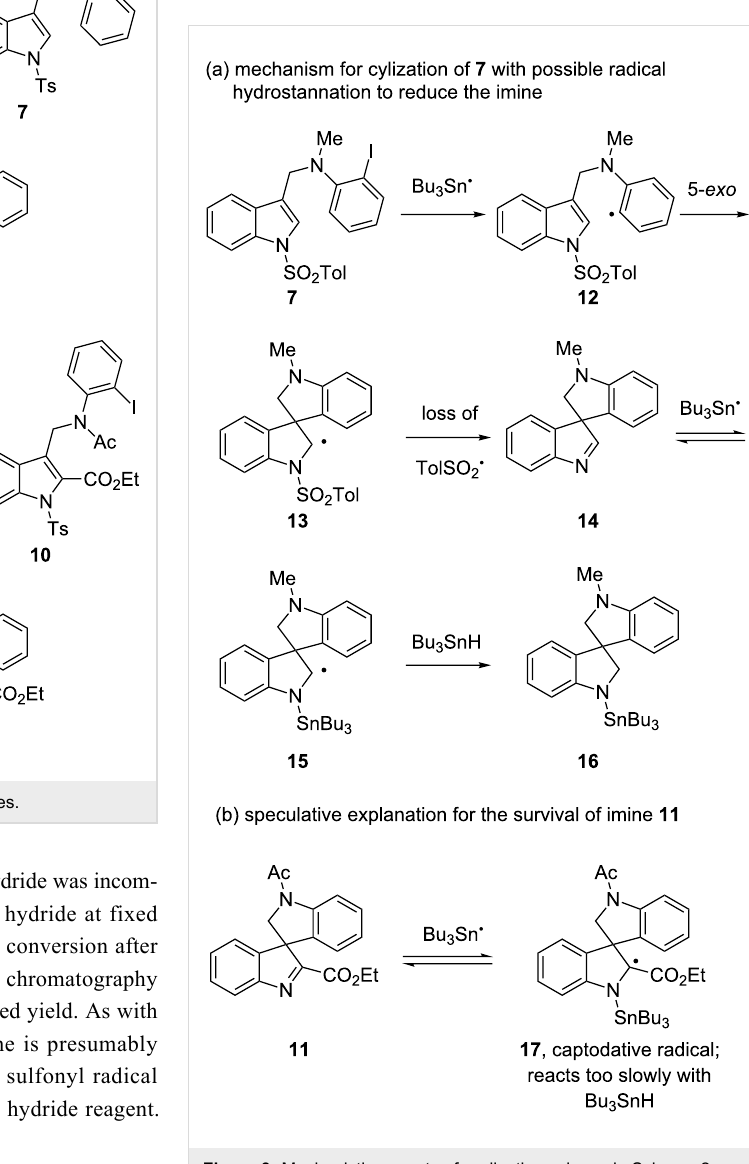
Figure 3: Mechanistic aspects of cyclizations shown in Scheme 2; (a) mechanism for formation of 7 ; (b) possible reason for survival of 11